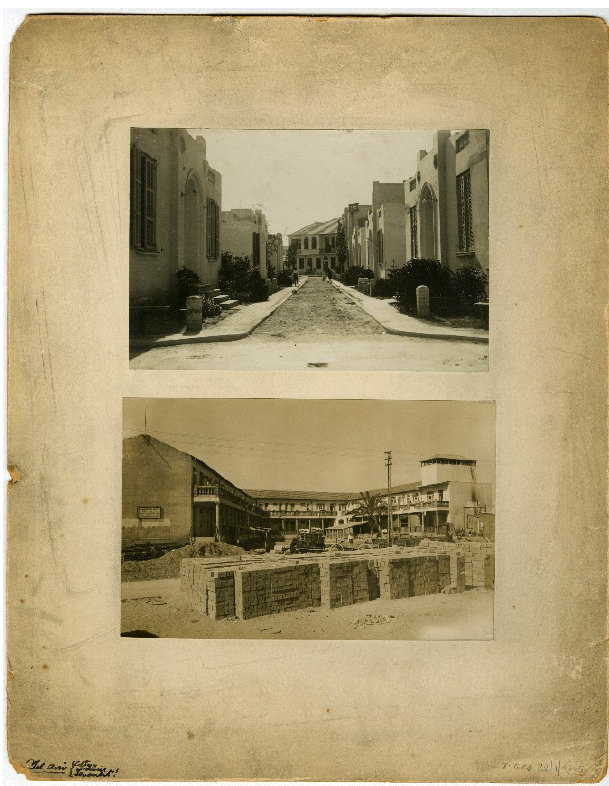
Figure 6. The Shapira Alley cottages versus nearby tenement (author unknown). Source: Patrick Geddes Papers (n.d.). Urban Planning, 2019, Volume 4, Issue 3, Pages